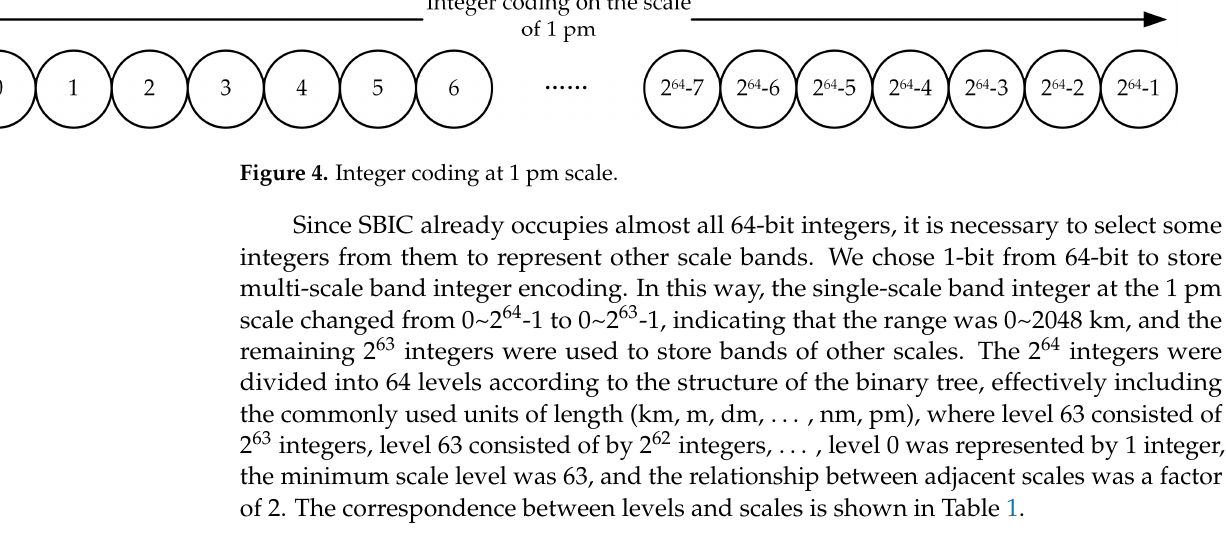
Table 1. Corresponding levels of different scales.